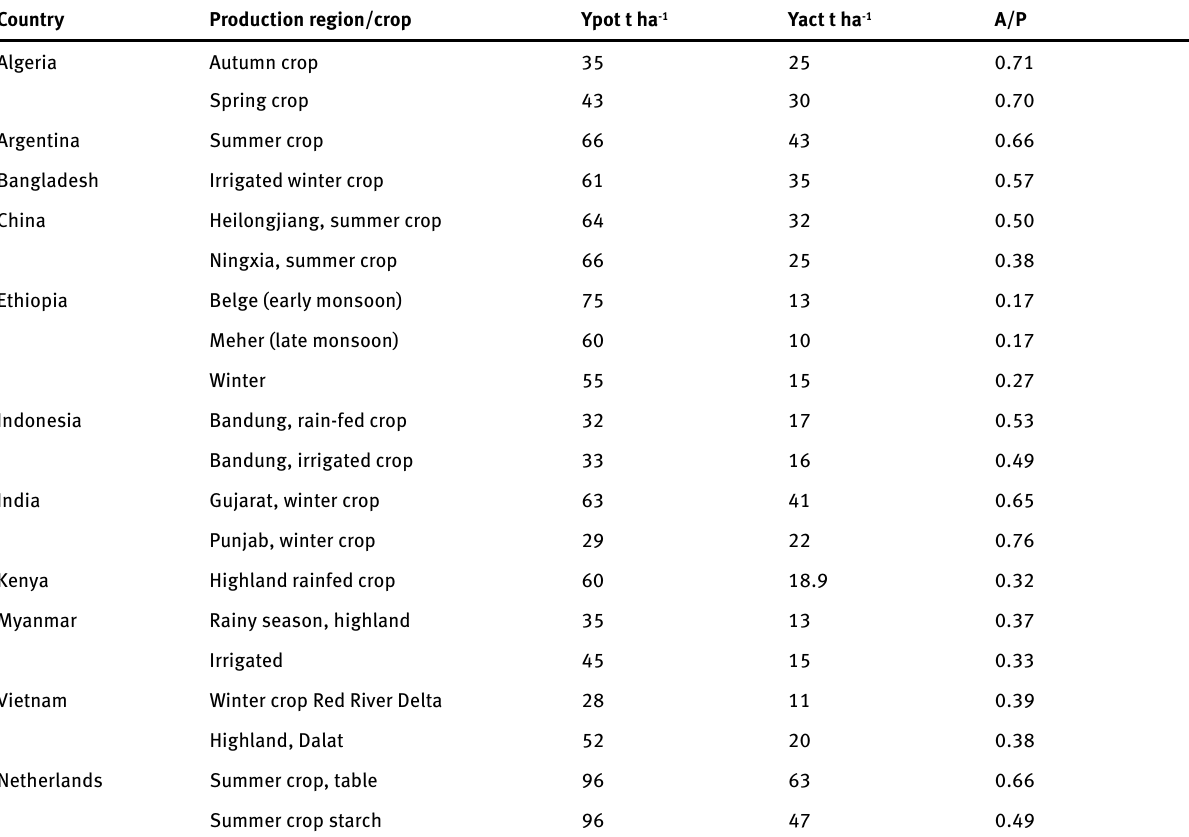
Table 3: Potential (Ypot) and actual (Yact) yields and their ratio (A/P) calculated with LINTUL-POTATO-DSS (Haverkort et al. 2012)